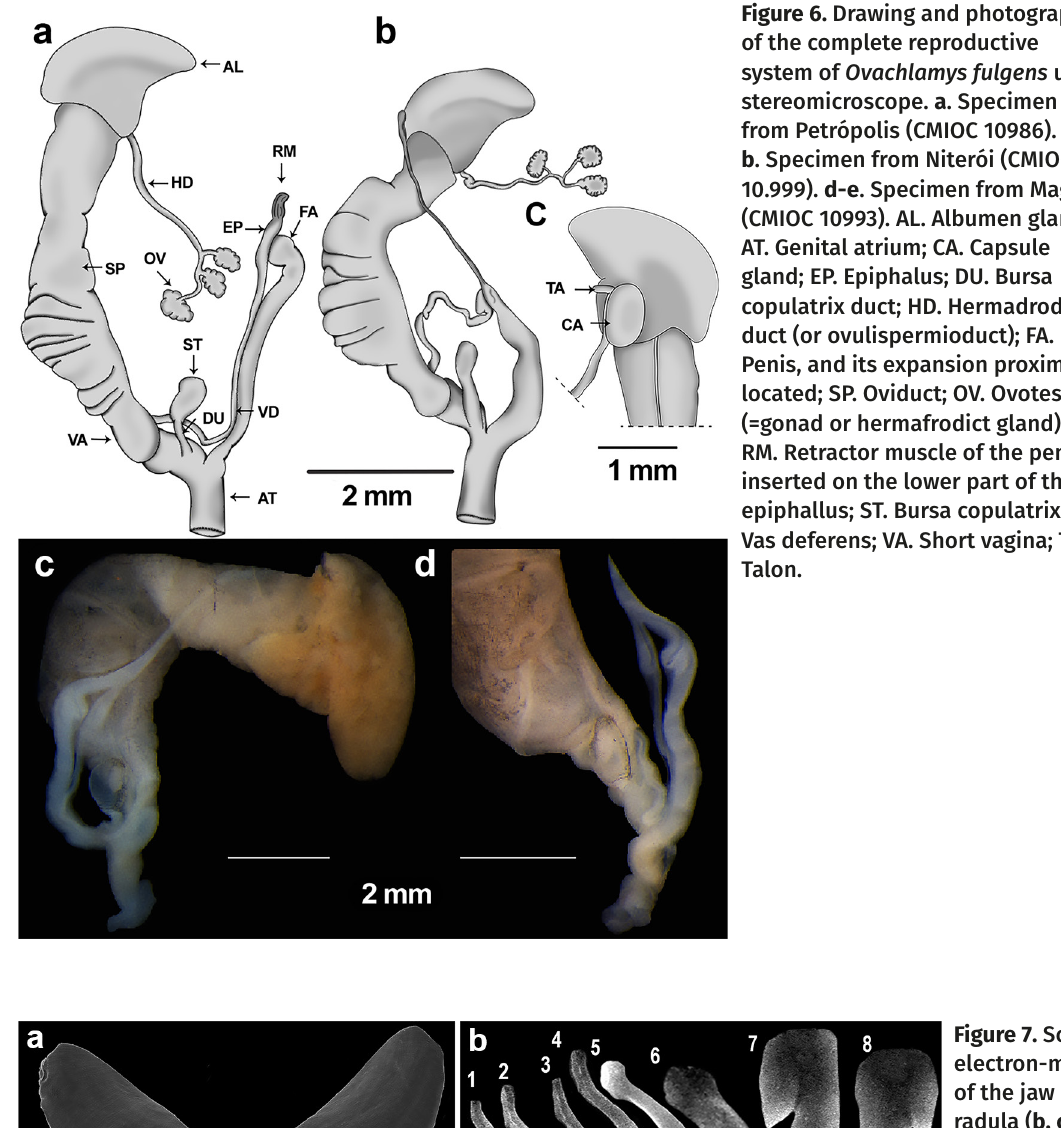
Figure 7. Scanning electron-micrographs of the jaw ( a ) and radula ( b, c, d ). b . Different types of teeth found in the Ovachlamys fulgens radula. c . Left side of the radula, showing lateral and marginal teeth (COMIC 11000). d . Left and right sides of the